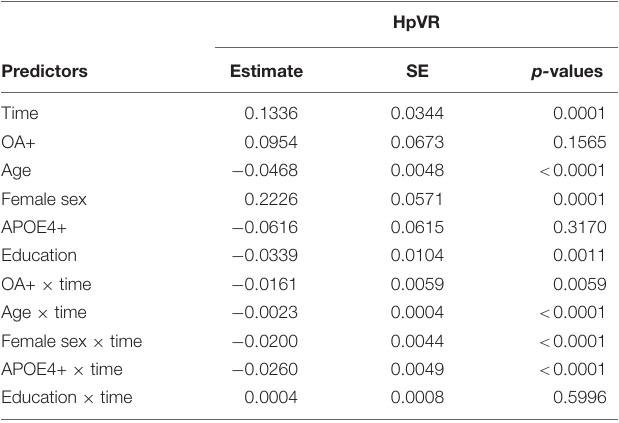
FIGURE 4 | Association of OA with change in HpVR among individuals with NC. Compared with individuals without OA, those with OA showed a significantly steeper decline in HpVR (estimate: –0.0161, p = 0.0059) after adjusting for other potential confounders. OA: osteoarthritis; HpVR: HpVR